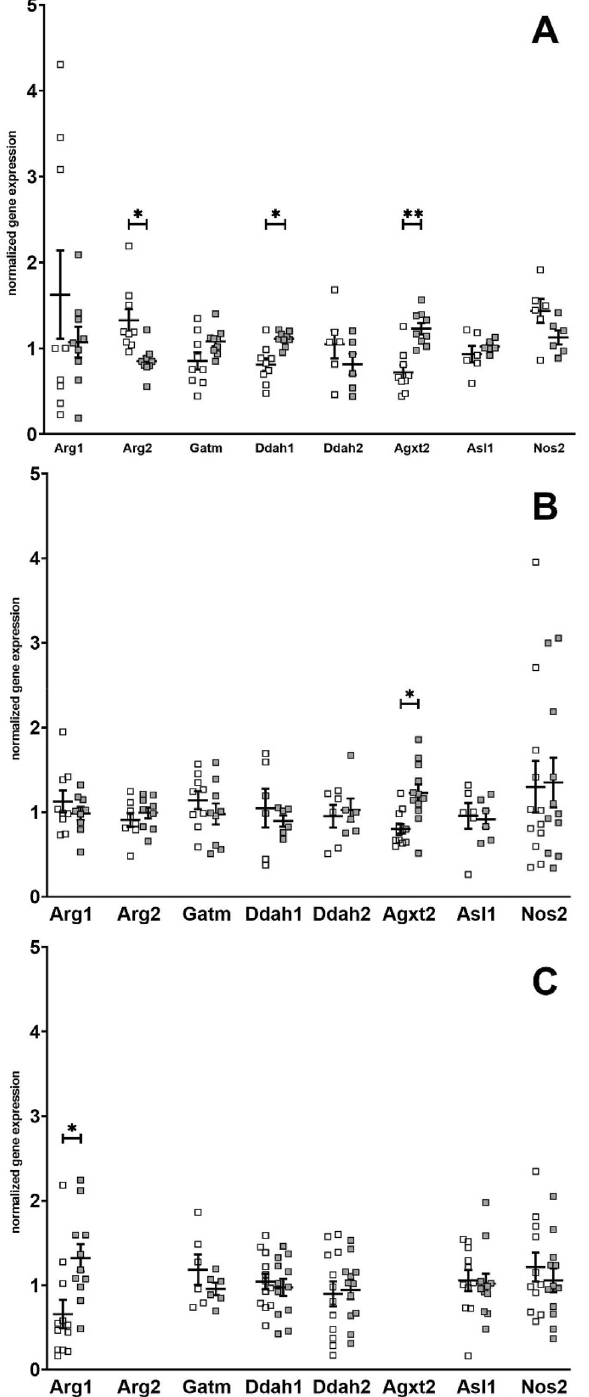
Figure 1. Gene expression of key enzymes involved in arginine metabolism in kidney ( A ), liver ( B ) and heart ( C ) in L-ZSF1 (white squares) and O-ZSF1 (grey squares). Y-axis shows arbitrary units that represent gene expression normalized to Hprt1 and the median of all measurements of the gene. Arg2 and Agxt2 expression in heart was generally low and not detectable in some animals (cycle threshold > 35) irrespective of phenotype and was thus excluded from view. Boxplots visualize the median, 25th and 75th percentiles and minimum/ maximum. P -values were calculated using Kruskal–Wallis test and were corrected for multiple testing using the Bonferroni-Dunn method. * p < 0.05, ** p <